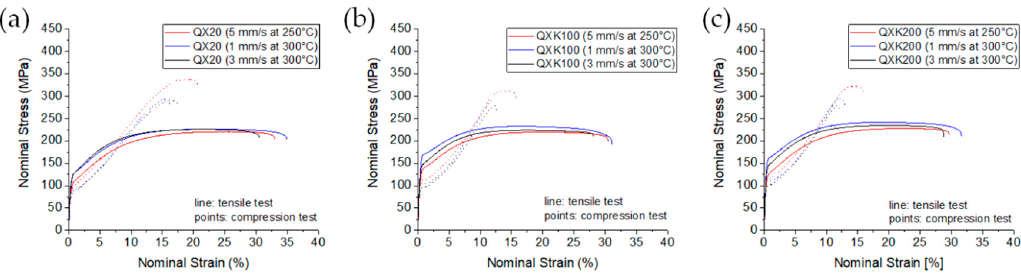
Figure 6. Stress–strain diagrams from tension and compression tests at ambient temperature: ( a ) QX20; ( b ) QXK100; ( c ) QXK200. Table 5. Mechanical properties from tensile and compression tests in Figure 6 for the QX-series alloys. TYS: tensile yield stress, UTS: ultimate tensile stress, CYS: compressive yield stress, UCS: ultimate compressive stress; errors in brackets.